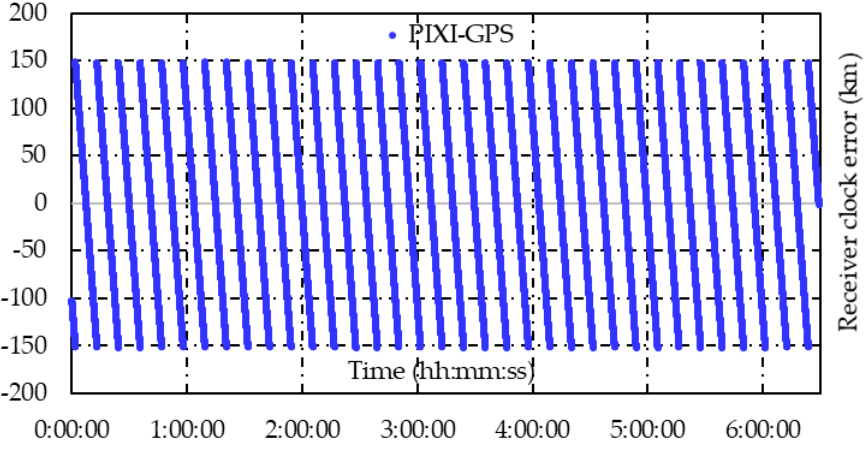
Figure 14. Receiver clock error of PIXI with GPS.